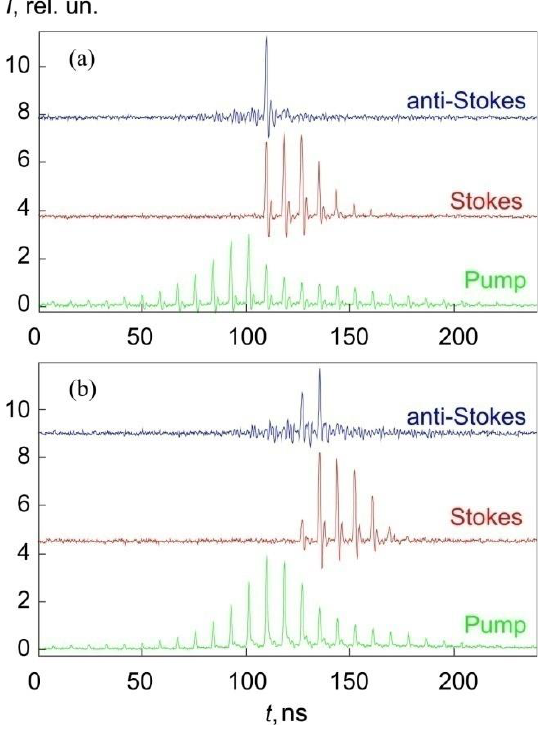
Figure 5. Oscillograms of the laser radiation at the rotation angle of the active CaMoO 4 element equal to ( a ) φ = 27 о and ( b ) φ = 32 о .